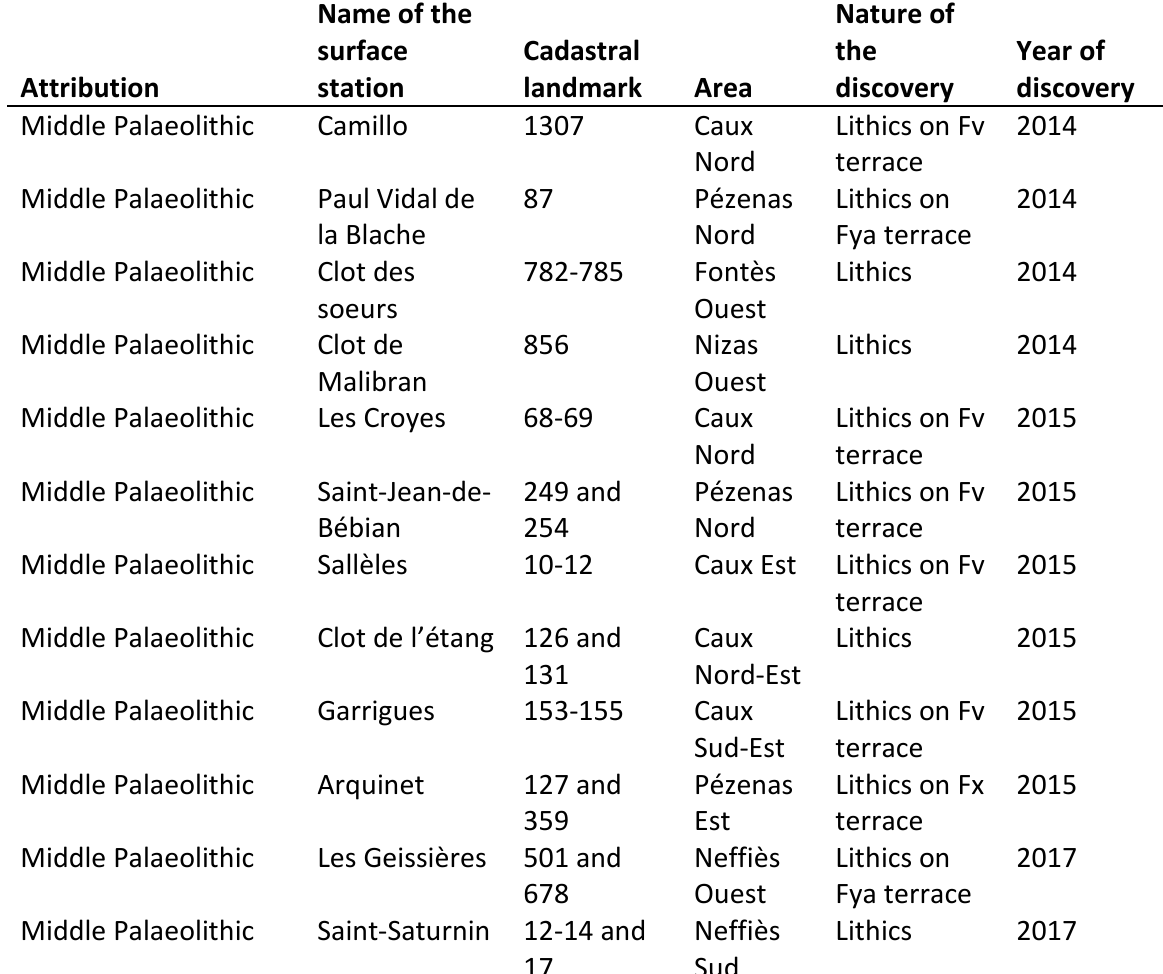
Table 1. Middle Palaeolithic surface stations discovered during the survey, between 2014 and 2017. In bold, the sites presented in this